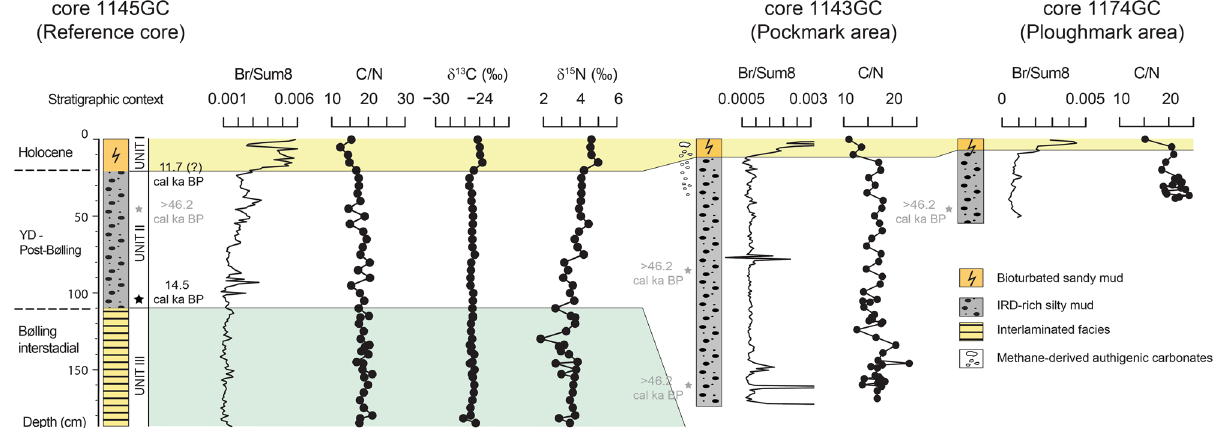
Figure 2. Chronostratigraphic model of reference core 1145GC and correlation with cores 1143GC and 1174GC. Core 1145GC has been subdivided into three lithostratigraphic units and interpreted based on a radiocarbon tie point at the base of Unit II and integrated with paleoproductivity proxies and organic matter parameters (Br/Sum8, C/N ratio, δ 13 C, δ 15 N) to identify the Holocene sediment interval (Unit I). The typical marine organic matter is composed of plankton and algae and is characterized by C/N values between 4 to 10, δ 13 C org between −23 and −16‰ and δ 15 N as high as 7‰ 78–80 . Terrestrial organic matter mainly includes material from vascular land plants showing C/N values above 20 79 , lighter δ 13 C values ranging from − 29.3‰ to − 25.5‰ 81 and δ 15 N close to atmospheric nitrogen composition (~ 0‰) 78 . Mollusc shells collected from Unit II in